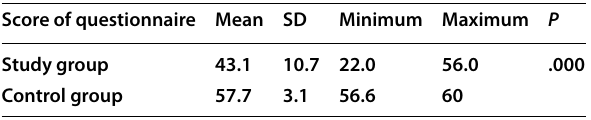
Table 4 Mean and SD of score of questionnaire among study and control groups